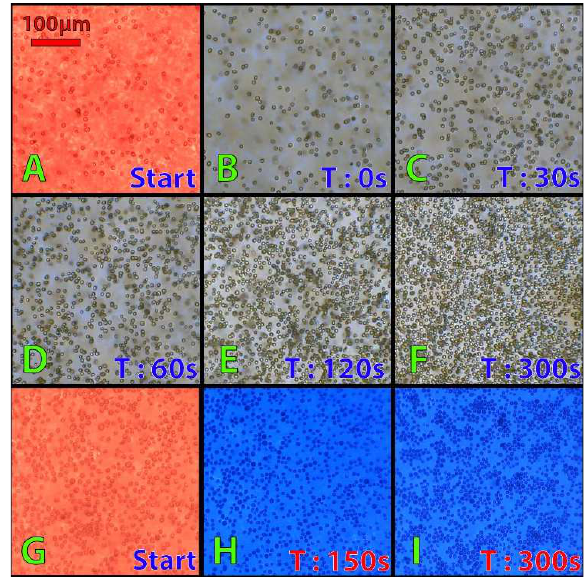
Figure 13. Effect of light color on microalgae motility. Aggregation of C. reinhardtii cells (7 × 10 6 cells mL −1 ) exposed to white light ( A – F ) or blue light ( G – I ) after a 5 min treatment with red light. The